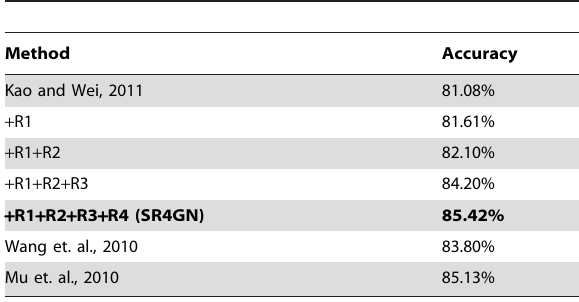
Table 2. Evaluation on species assignment using the DECA corpus from Wang et al., (2010).